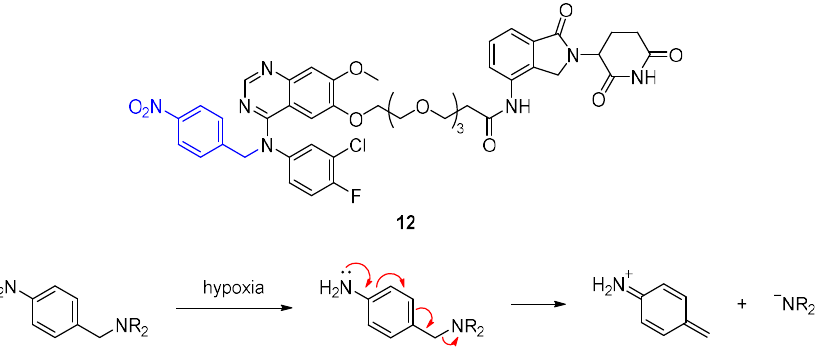
Figure 8. Hypoxia-activated EGFR PROTAC 12 selectively degrades its target under hypoxia, when the 4-nitrobenzyl group (blue) is reduced by nitroreductases and cleaved from the PROTAC to give the corresponding secondary amine.